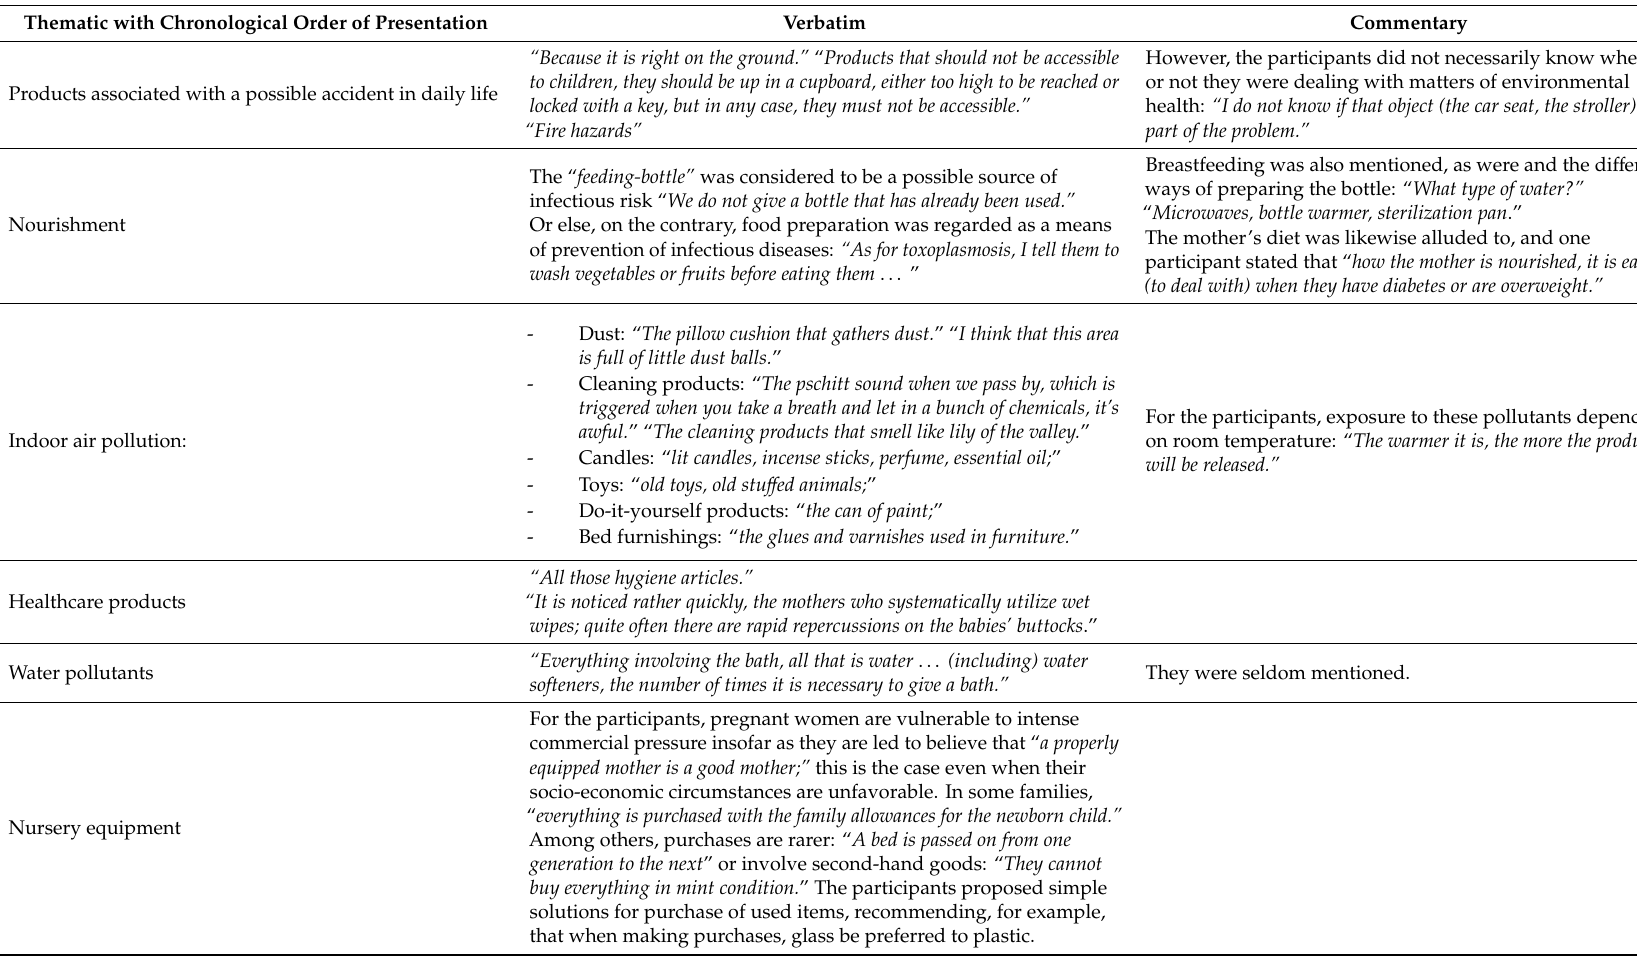
Table 2. Representations of perinatal professionals about environmental risks viewed by